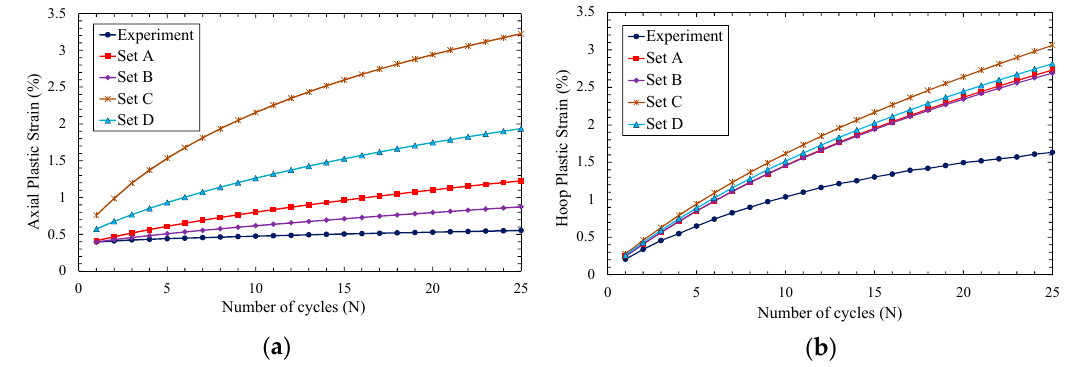
Figure 19. Chaboche model of ratcheting simulation results using ratcheting parameters presented in Table 4. ( a ) Uniaxial ratcheting rate, ( b ) biaxial ratcheting rate.